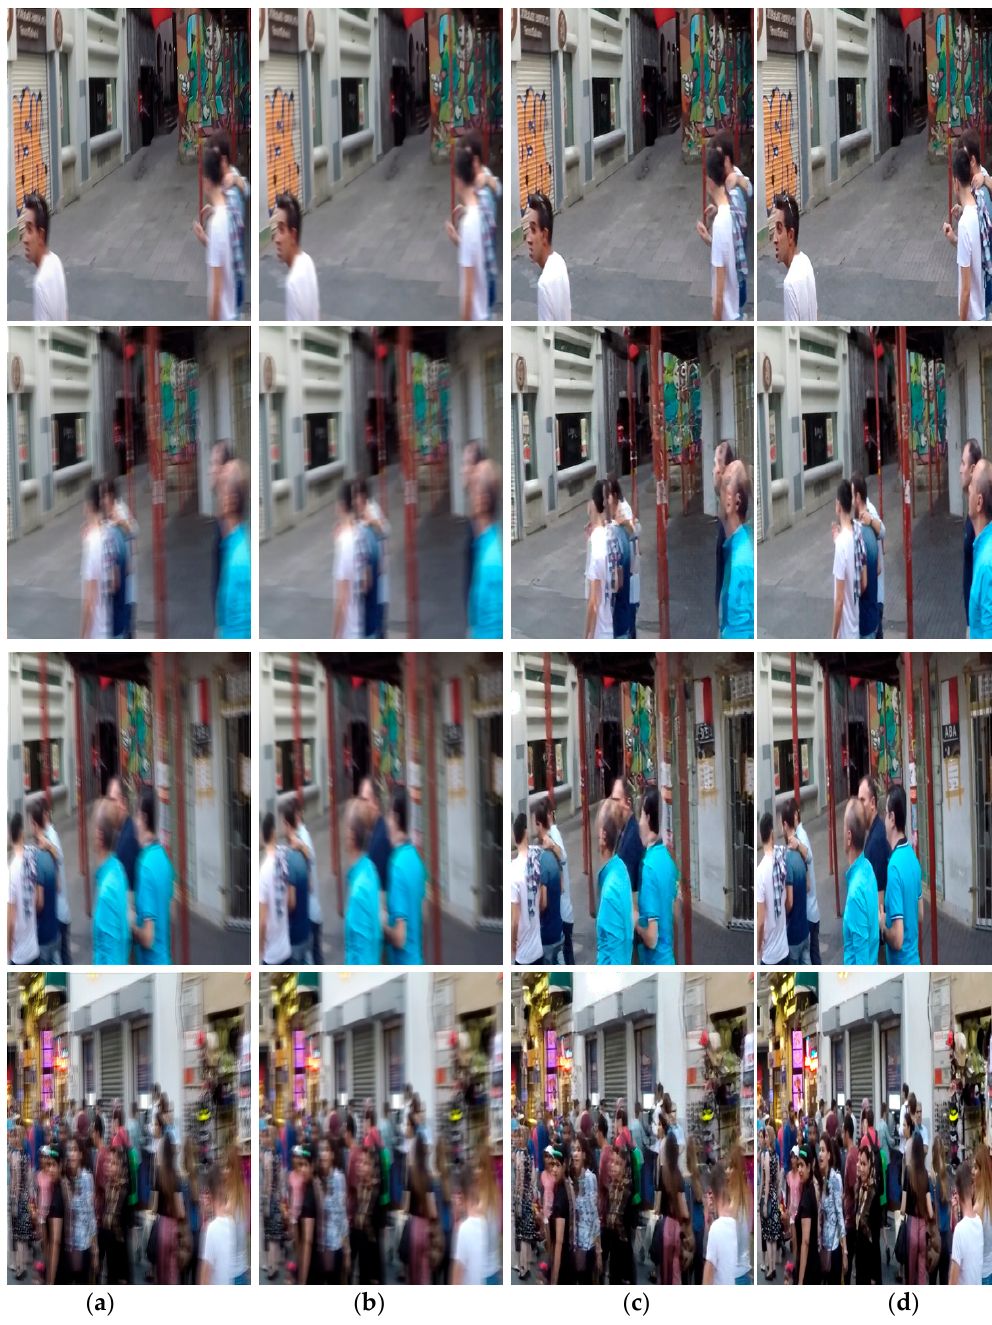
Figure 16. Object images from comparing proposed method with filter-based methods: ( a ) Wiener filter ( b ) Bilateral filter ( c ) Proposed method ( d ) Original sharp image.